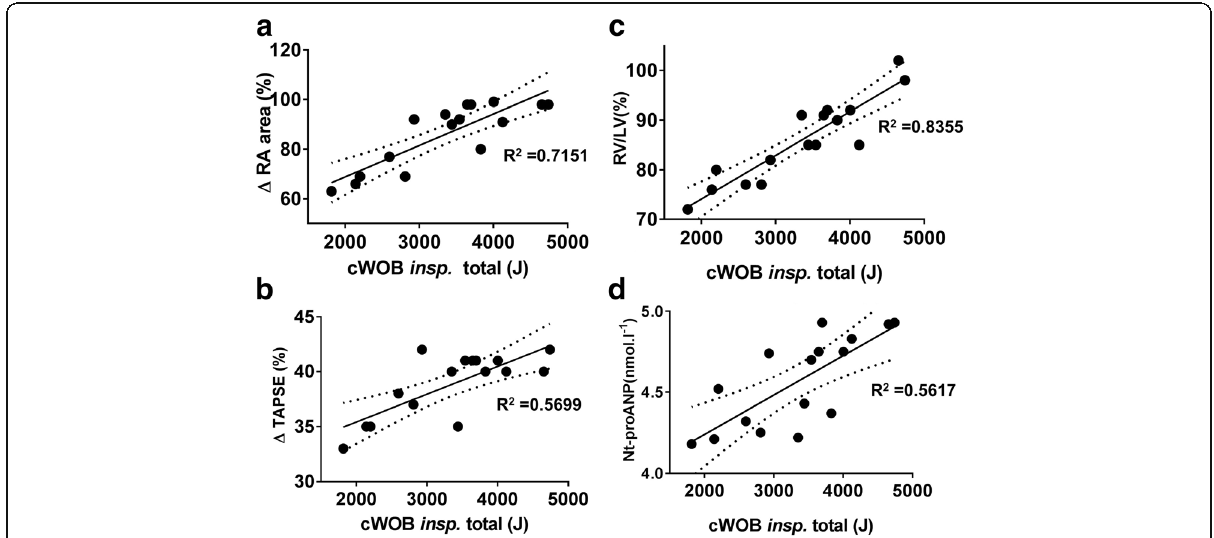
Fig. 4 Correlations observed between individual cumulated inspiratory work of breathing and the corresponding percent changes in right atrial volume ( a ), rise in TAPSE ( b ), in RV/LV ratio ( c ), and the final plasma Nt-proANP concentration ( d ), during the fin exercise dive with negative transpulmonary pressure. cWOB insp, cumulated inspiratory work of breathing; Δ RA area, change in right atrial area; Δ TAPSE, change in tricuspid annular plane systolic excursion; RV/LV, ratio of right to left ventricles end-diastolic area; Nt-proANP, plasma concentration of